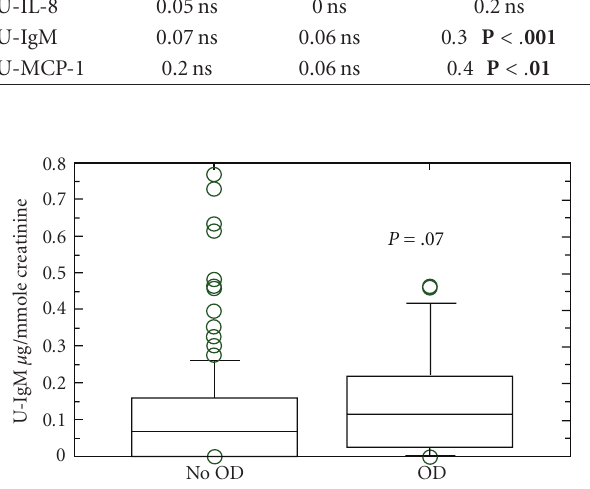
Figure 2: U-IgM as prognostic marker No OD: no develop- ment of critical damage according to VDI during followup. OD: development of critical damage according to VDI. All patients in stable phase of the disease when the sample was taken (7 in remission and 8 with smouldering disease; 50 in remission and 17 with smouldering activity in the group who did not develop OD, presented as μ g IgM/mmole creatinine. The box plot shows median value, with 95% confidence